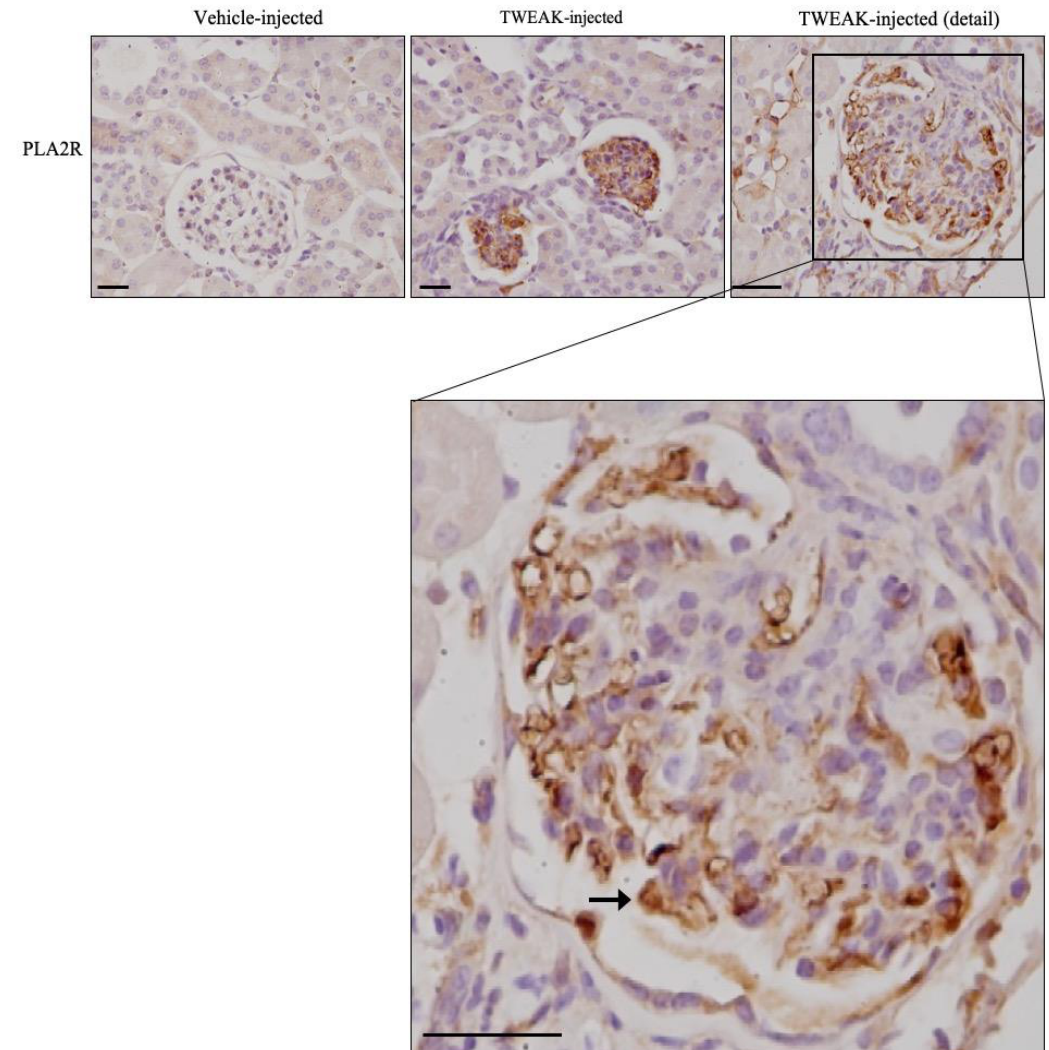
Figure 3. TWEAK increases PLA2R expression in podocytes in vivo. Immunohistochemistry showing that systemic TWEAK injection in healthy mice increased glomerular PLA2R immunostaining in vivo after 24 h. Under baseline control conditions, glomerular PLA2R immunostaining was negative, as expected from single cell transcriptomics studies that only reflected low (6.5% of the cells) Pla2r gene expression in endothelial cells and lack of expression in all other kidney cells [17]. The pattern of glomerular PLA2R immunostaining in TWEAK-injected mice, in the periphery of glomerular capillary walls and in the body of cells sitting outside the capillaries and protruding towards Bowman’s capsule was consistent with the increased podocyte expression of PLA2R (arrow). Representative images from n = 4 animals per group. Original magnification ×20, scale bar 20 µm.